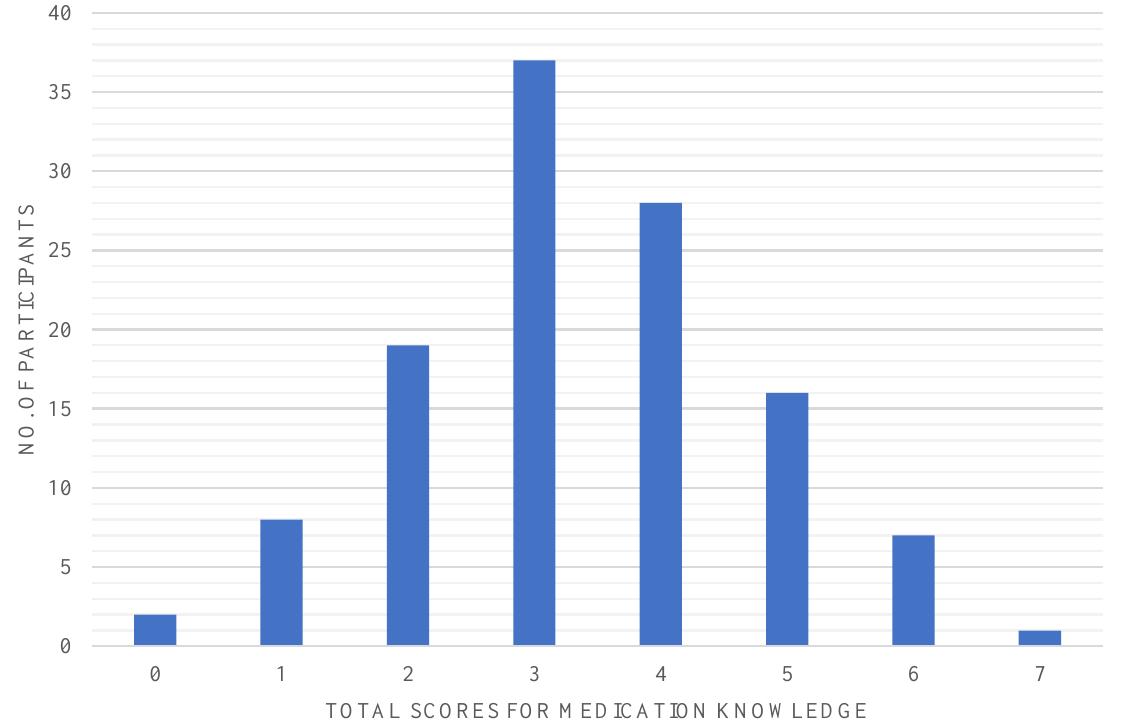
Figure 2. Distribution of the number of participants and their scores for the medication knowledge questionnaire.